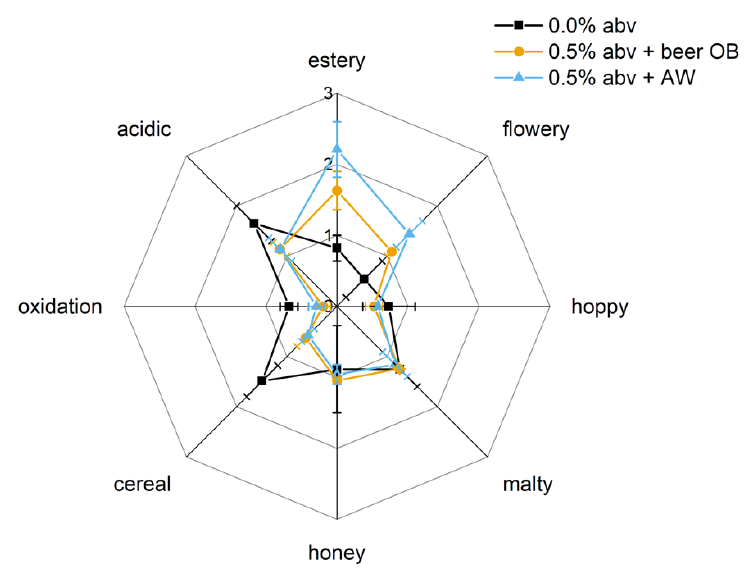
Figure 6. Radar diagram reflecting the sensory evaluation of a non-alcoholic beer (NAB) produced with the DeAlcoTec ® thermal dealcoholisation system and of two blends with original beer (beer OB) and aromawater (AW); the dealcoholisation experiment was conducted at an evaporation temperature of 36 °C, a condenser temperature of 10 °C and a reflux rate of 60 L h −1 ; in the radar diagram, the intensities are rated as follows: 1 = low, 2 = medium, 3 = strong (𝑥̅ ± 𝜎) .